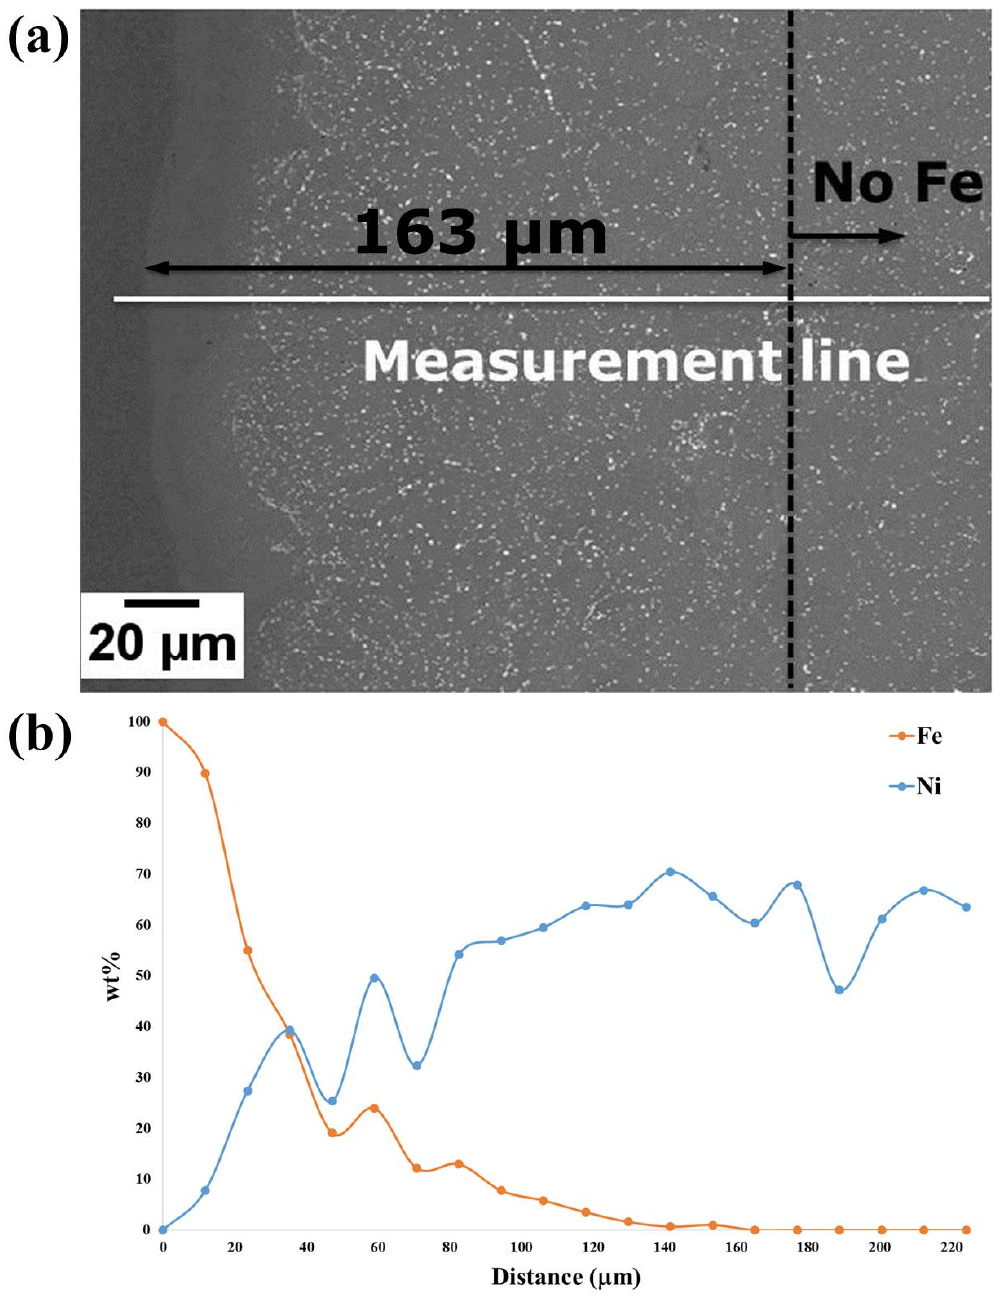
Figure 15. ( a ) BSE micrograph for the sample cut from the Fe-tooling SLM / HIPped can prior to pickling; ( b ) EDX line result along the measurement line indicated in (a); it is shown that Fe decreases to ~0 wt.% at around 163 µm.